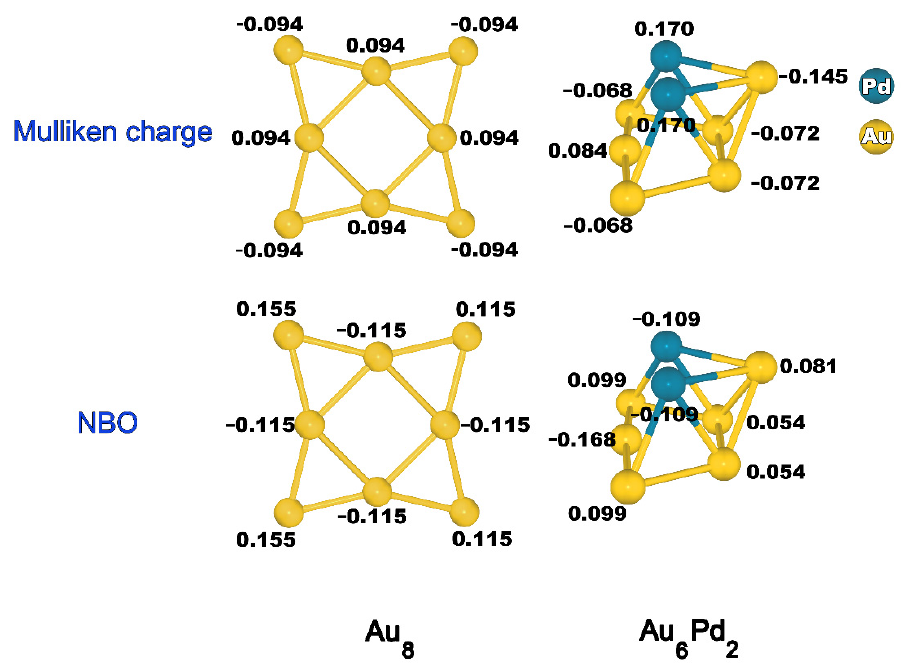
Figure 1. The lowest-energy structure of Au 8 and Au 6 Pd 2 with Mulliken atomic charges, and NBO analysis. NBO